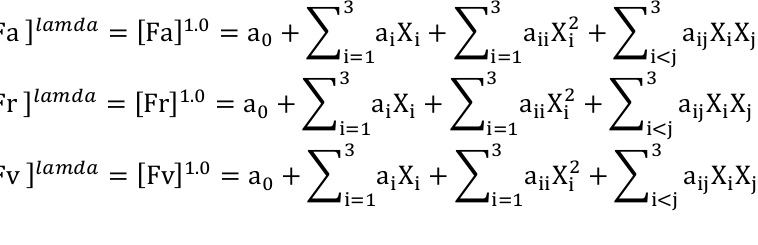
Analysis of variance for Fa, Fr and Fv